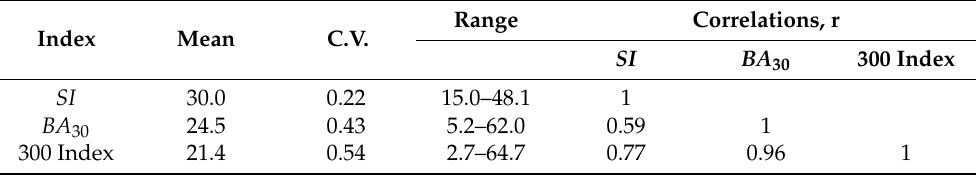
Table 11. Comparison of productivity indices for redwood. Shown are means and coefficients of variation (C.V.) for the indices and their Pearson correlation coefficients.